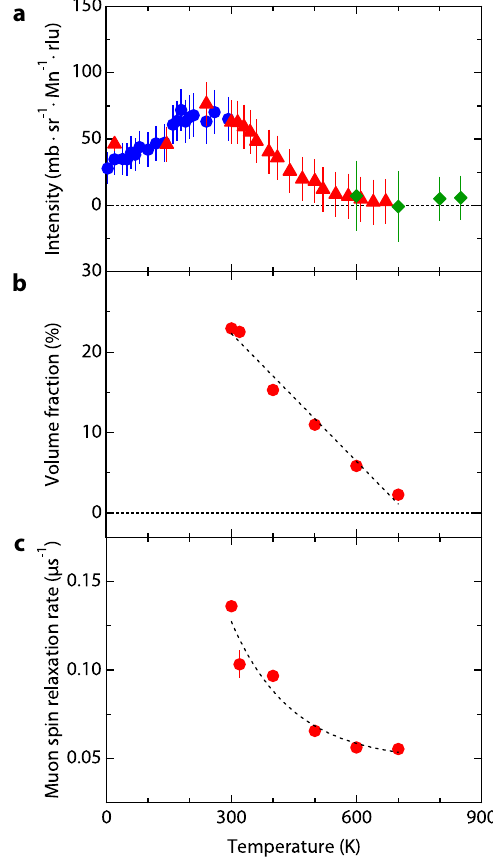
Fig. 3 Temperature dependence of magnetic diffuse scattering intensity, short-range order volume fraction, and muon spin relaxation rate. a Temperature dependence of the integrated magnetic diffuse scattering intensity near Q = 1.7 Å − 1 . The circles correspond to low-temperature cryostat measurements, the triangles correspond to cryofurnace measurements, and the diamonds correspond to furnace measurements. b Volume fraction of the magnetic short-range ordering component estimated from the normalized initial asymmetry. c Muon spin relaxation rate of the paramagnetic component, λ ( μ s − 1 ). The data point for 320 K was